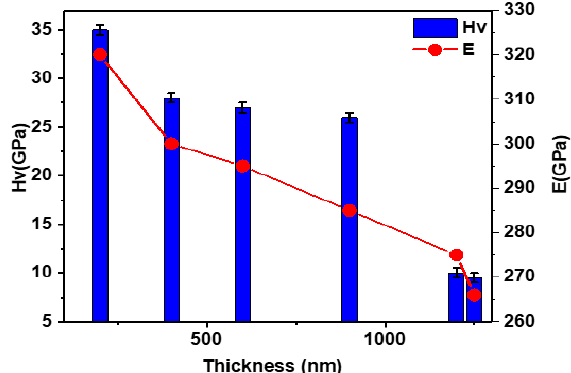
Fig. 9. Hardness and Young’s modulus in the MoN film vs thickness.